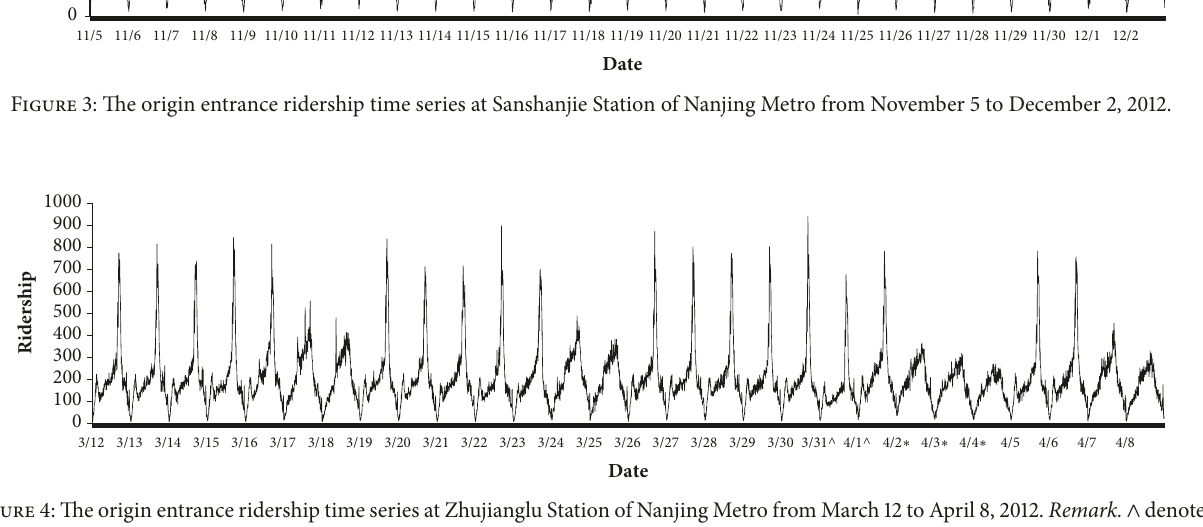
Figure 4: The origin entrance ridership time series at Zhujianglu Station of Nanjing Metro from March 12 to April 8, 2012. Remark. ∧ denotes that the weekend changes the weekday; ∗ denotes that of the